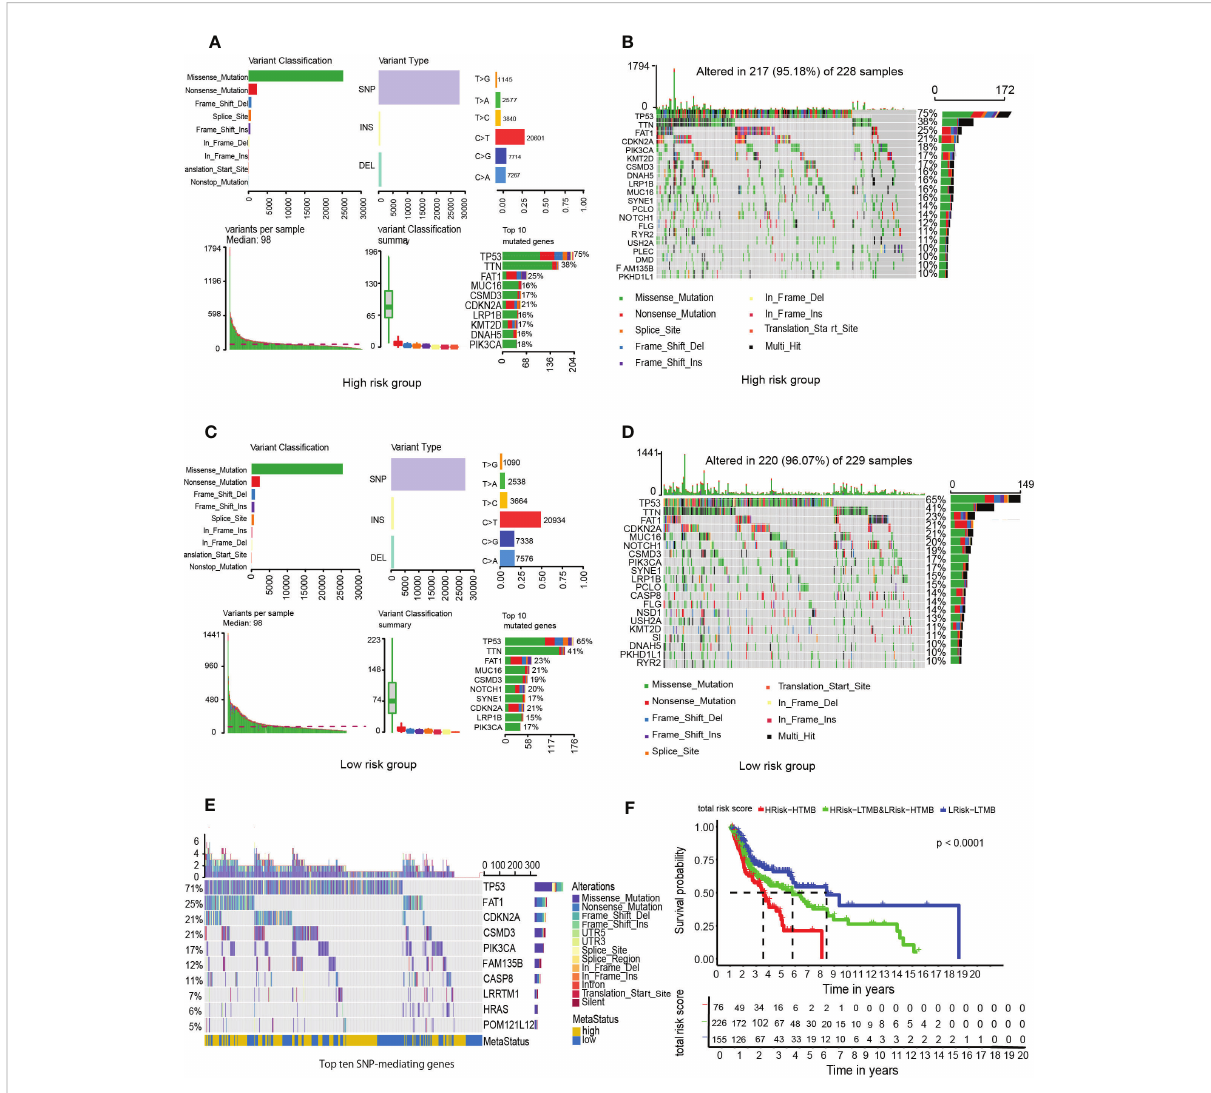
FIGURE 7 Analysis of tumor mutation burden among HNSCC patients. (A) High-GRGPI. (B) High-GRGPI group mutation types and top 20 mutated genes in the sample. (C) Low-GRGPI. (D) low-GRGPI group top 20 mutated genes. (E) Mutation types of the top ten SNP-driven genes and their distribution in high-GRGPI group and low-GRGPI group. (F) Kaplan-Meier survival curve showing OS differences among the three